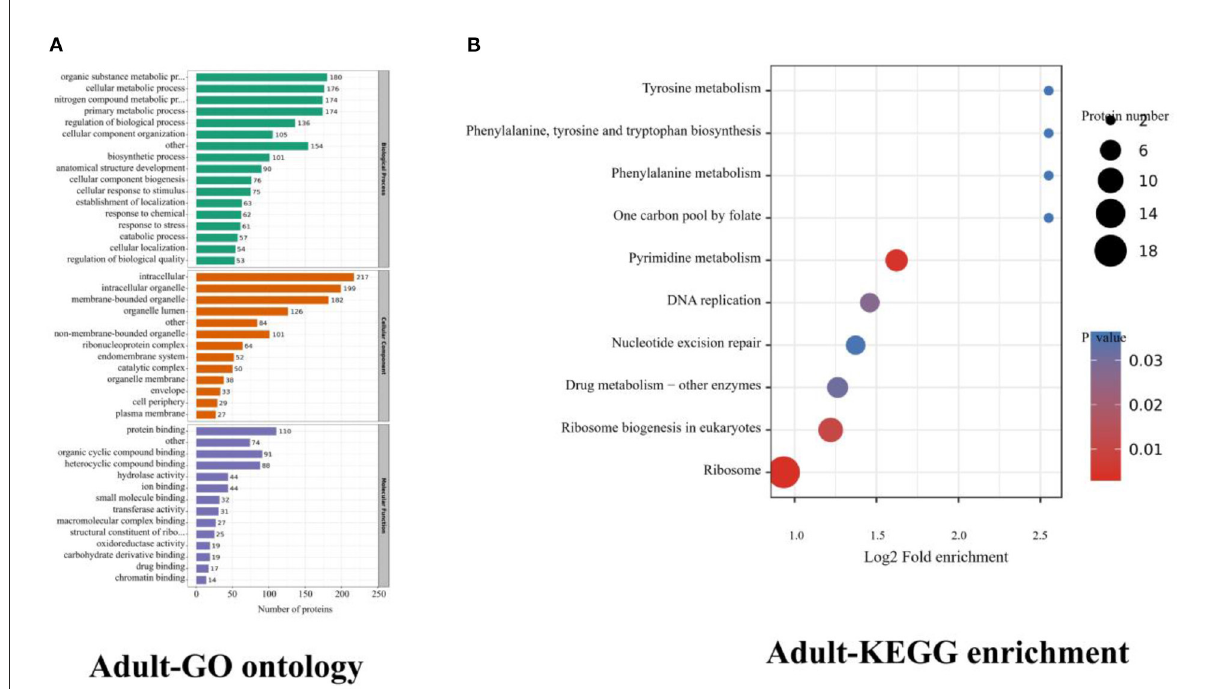
FIGURE3 Adults (upregulated) proteins GO ontology and KEGG enrichment. (A) Gene ontology (GO) of adults, dividing the annotated proteins into 3 categories: cellular component, molecular function, and biological process. The number of genes is expressed as the number of annotation proteins. (B) KEGG enrichment analysis of identified proteins in